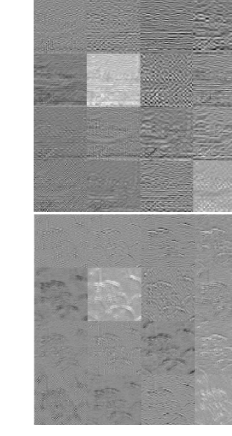
Figure 9. Filtered images of layer 6 and 15 kernels.